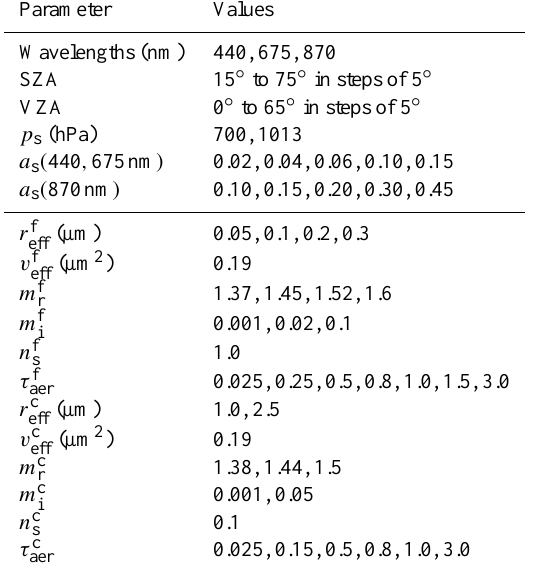
Table 1. LUT entries for each radiative transfer model parameter. The model parameters are solar zenith angle (SZA), viewing zenith angle (VZA), surface pressure ( p s ) , surface albedo ( a s ), aerosol ef- fective radius ( r eff ), effective variance ( v eff ), refractive index real part ( m r ) and imaginary part ( m i ), fraction of spherical particles ( n s ) and aerosol optical thickness (AOT). The superscripts f and c on the symbols of the aerosol parameters indicate the fine and the coarse mode